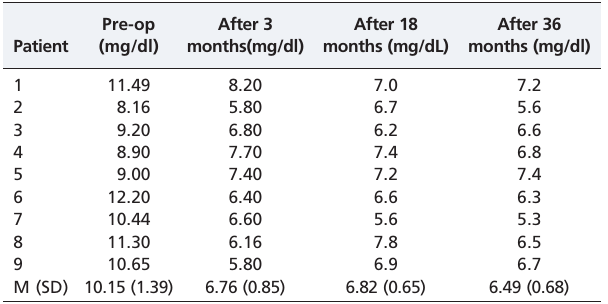
Table 4 - Glycated hemoglobin (HbA1c%): Comparison between preoperative values and values at 3, 18, and 36 months after surgery. All postoperative values were significantly lower ( p , 0.05). M= mean; (SD) =standard deviation.